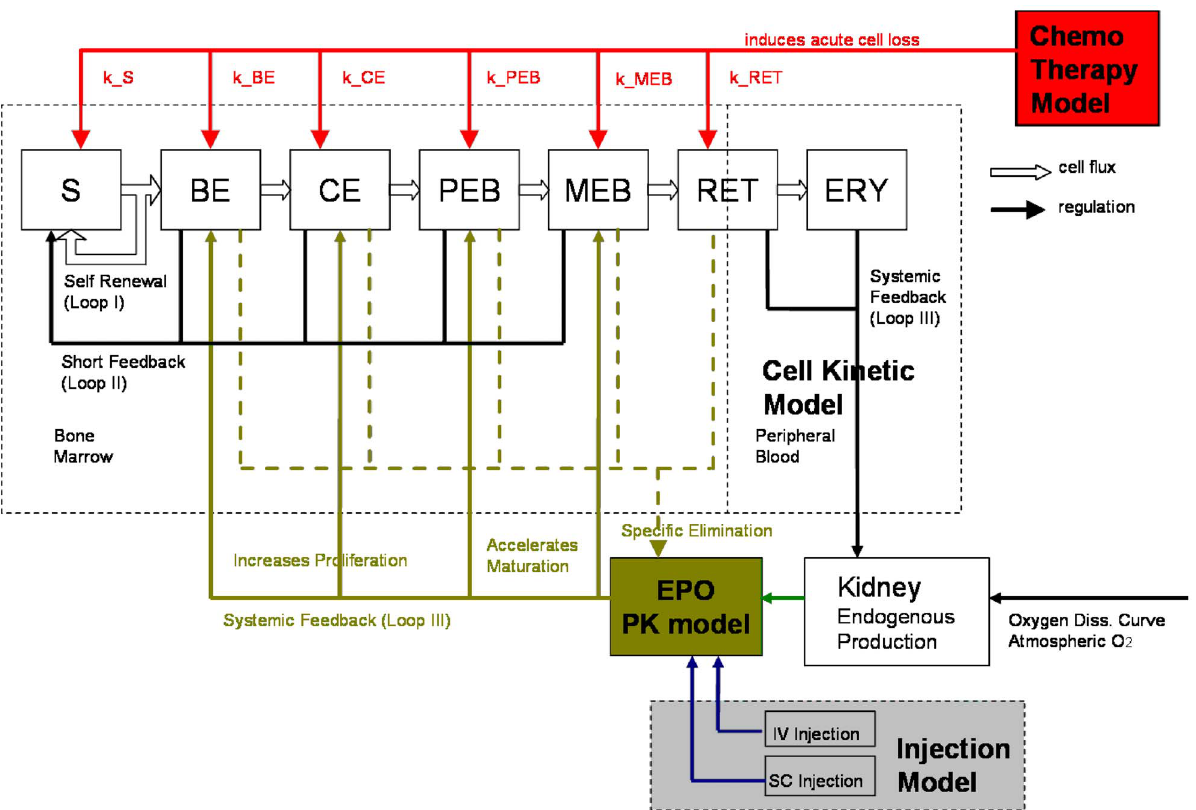
Figure 1. Structure of the model of erythropoiesis under chemotherapy and EPO application. We combined four independently developed models (cell kinetic, pharmacokinetic, injection, chemotherapy) into one comprehensive model. Model compartments are presented in boxes (S=stem cells, BE=burst forming units - erythroid, CE=colony forming units - erythroid, PEB=proliferating erythrocytic blasts, MEB=maturing erythrocytic blasts, RET=reticulocytes, ERY=erythrocytes, EPO=erythropoietin). Several regulatory feedback loops are implemented. The most important one is mediated by EPO which is produced endogenously and can also be applied externally. Chemotherapy is modelled by a transient depletion of cells.